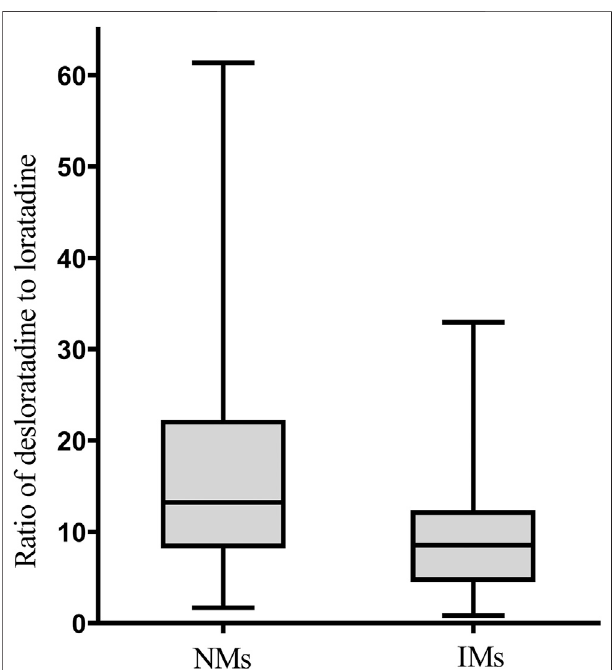
FIGURE 1 | Impact of CYP2D6 phenotypes on the M/P ratio of loratadine. The bars are medians, boxes are interquartile range, whiskers represent the min to max. Signi fi cant ( p (cid:1) 0.03) difference between NMs and